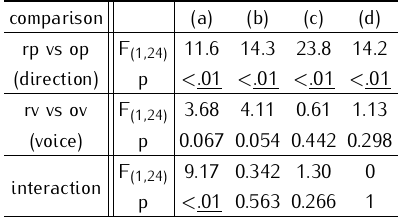
Table 7. Two-factor ANOVA of